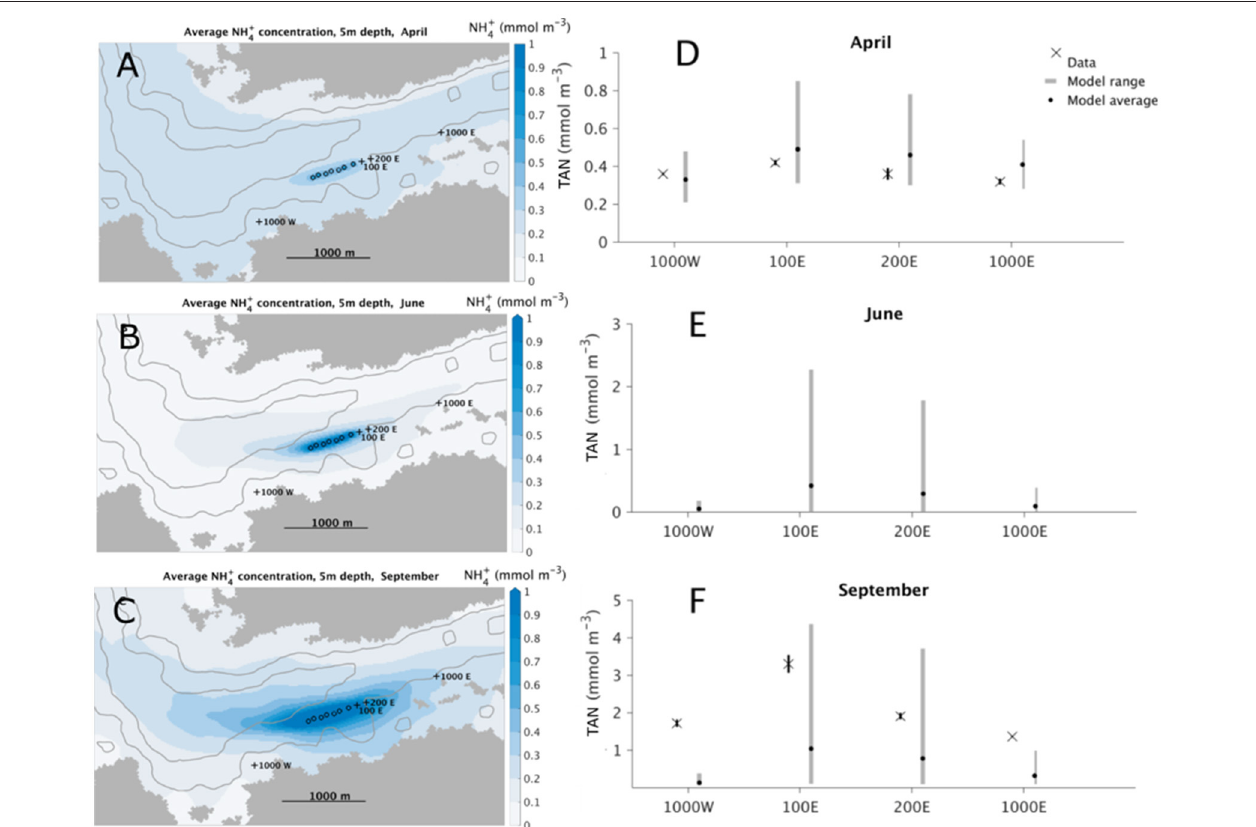
FIGURE 2 | Measure and modeled concentrations of TAN (mmol m − 3 ) in seawater at different stations in April, June and September 2013 (mean ± se, n = 3). (A–C) Simulated spatiotemporal extent of the effluent and background NH + 4 around the fish farm at Flåtegrunnen. (D–F) Simulated and measured NH + 4 -concentrations at all the stations at 5m depth for April (D) and September (F) , and simulated concentrations in June (E) . Black xs: measured concentrations; black dots: monthly mean simulated concentrations. Dark gray bars: range of simulated mean daily minimum to mean daily maximum concentrations without fish farm effluents. Light gray bars: range of simulated mean daily minimum to mean daily maximum concentrations with fish farm effluents.